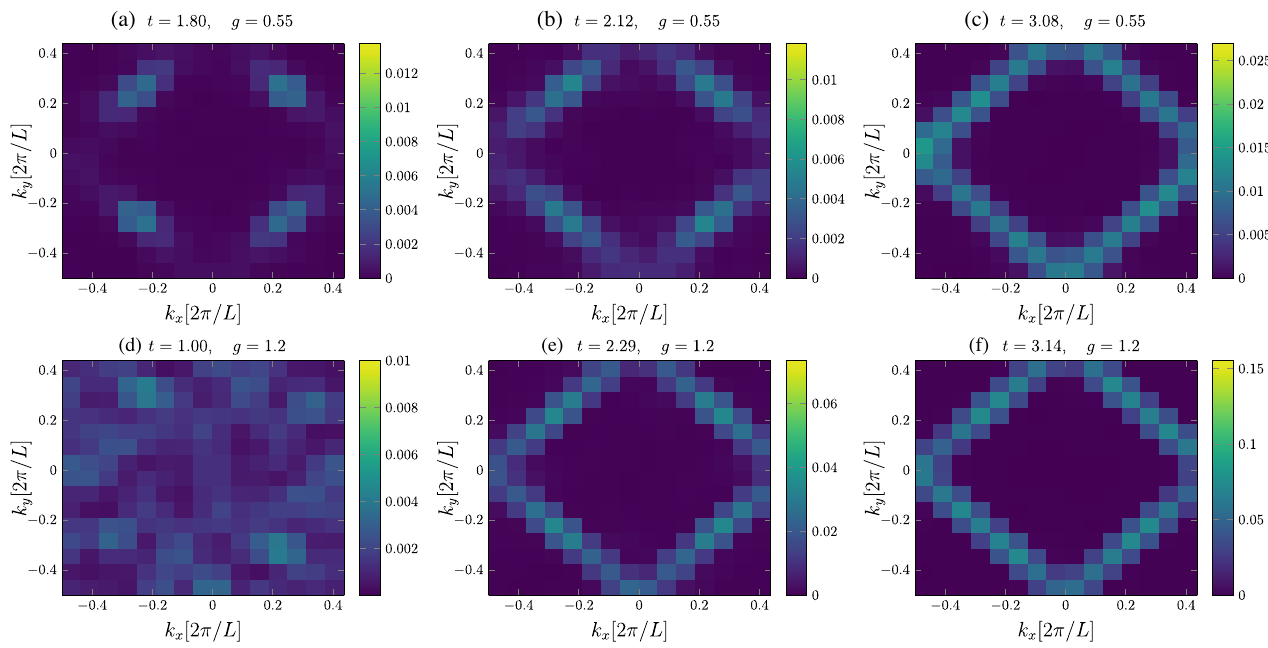
˜ Z FIG. 3. Momentum-resolved ð k Þ , for a linear system size L ¼ 16 and inverse temperature β ¼ 16 , as a function of the hopping amplitude t along two parameter cuts. (i) In (a) – (c), we fix g ¼ 0 . 55 and cross the transition between the OSM and deconfined FL phases. Deep in the OSM phase, we find four maxima with a finite spectral weight centered about k ¼ f(cid:2) π = 2 ; (cid:2) π = 2 g . With an increase in t , a large diamond-shaped Fermi surface gradually appears upon approach to the deconfined FL phase. (ii) In (d) and (e), on the other hand, we set g ¼ 1 . 2 and monitor the appearance of a Fermi surface, in the large t limit, starting from a featureless low-energy spectrum deep in the confined AFM